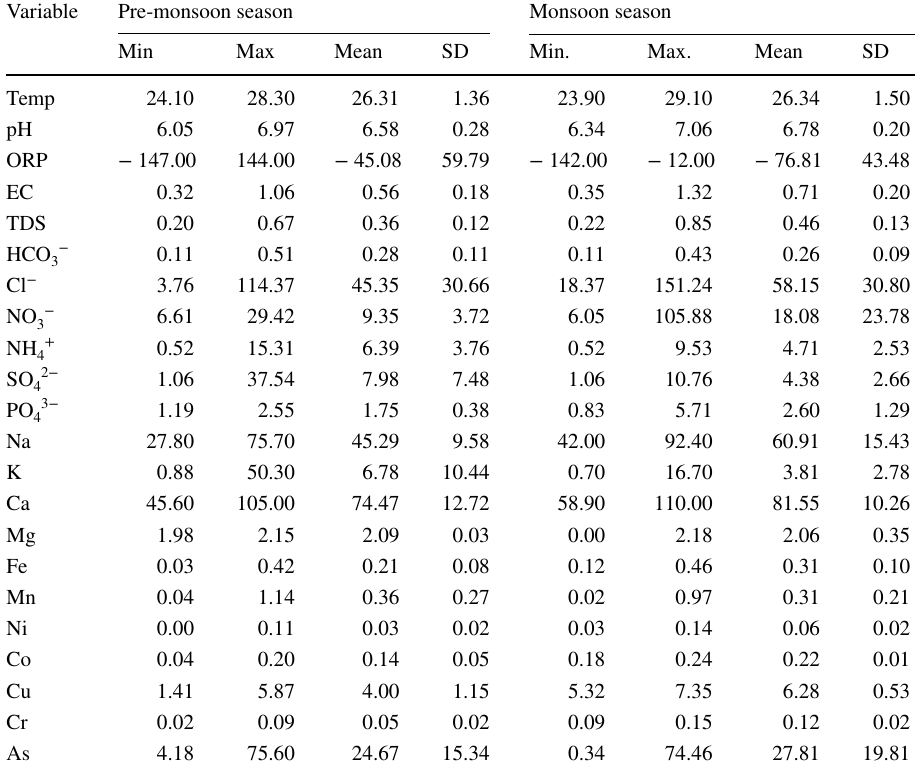
Table 4 Characteristics of groundwater